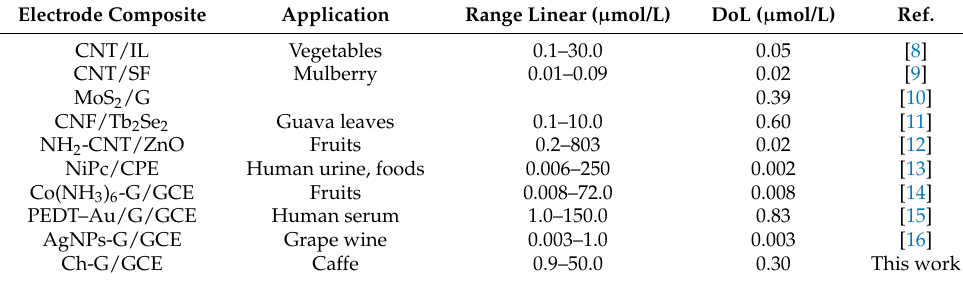
Table 3. Detection of MR with modified electrodes between 2014 and